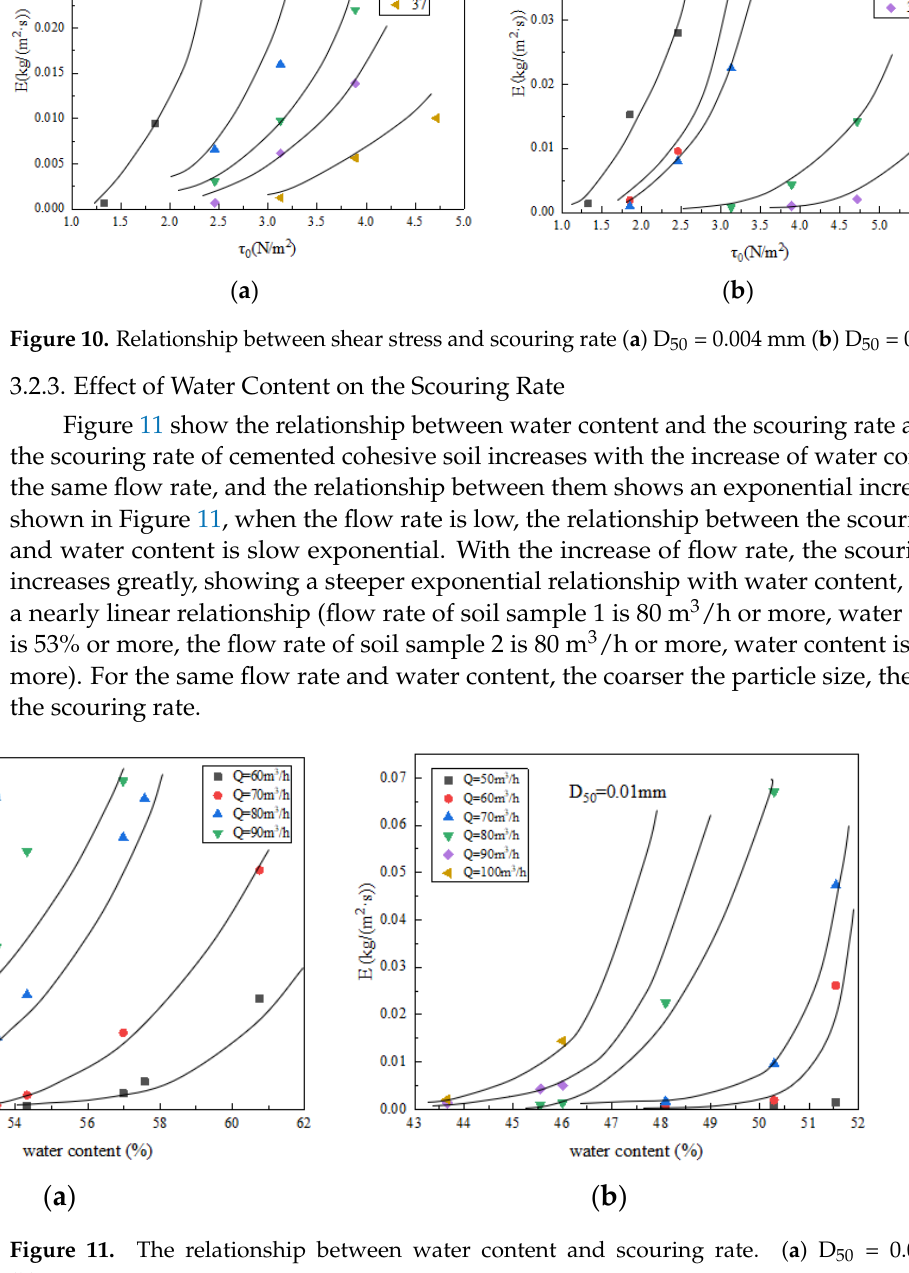
Figure 10. Relationship between shear stress and scouring rate ( a ) D 50 = 0.004 mm ( b ) D 50 = 0.01 mm.